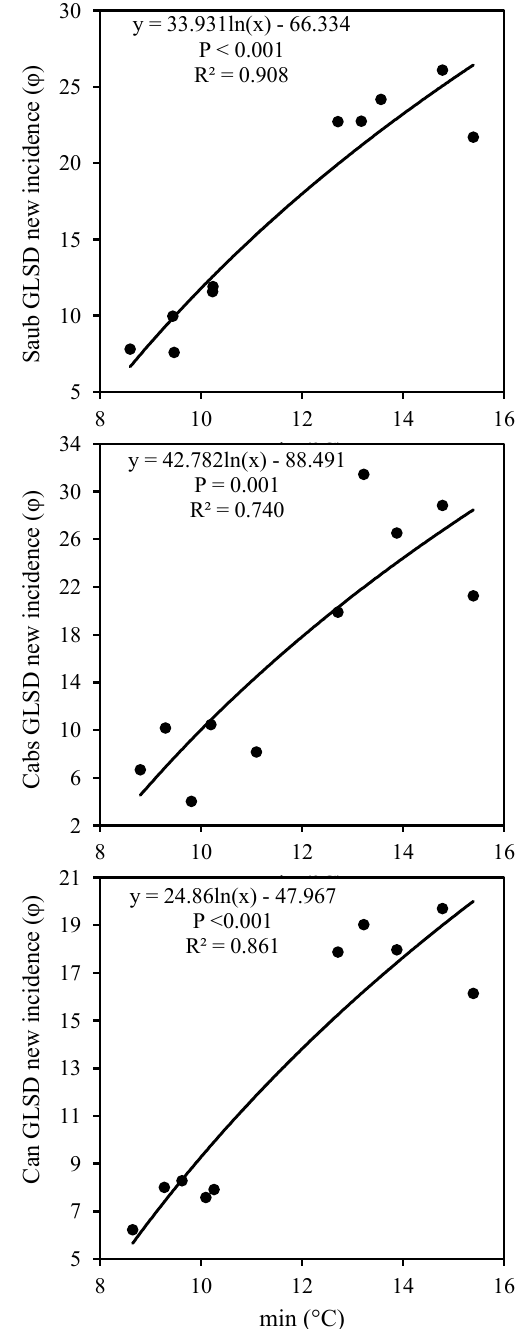
Figure 6. Regressions between arcsin-square root trans- formed (degrees ϕ) incidences of new Sauvignon blanc (Saub), Cabernet sauvignon (Cabs) and Cannonau (Can) plants showing GLSD foliar symptoms in the first and sec- ond assessment and average minimum temperature from 50% budding to the end of